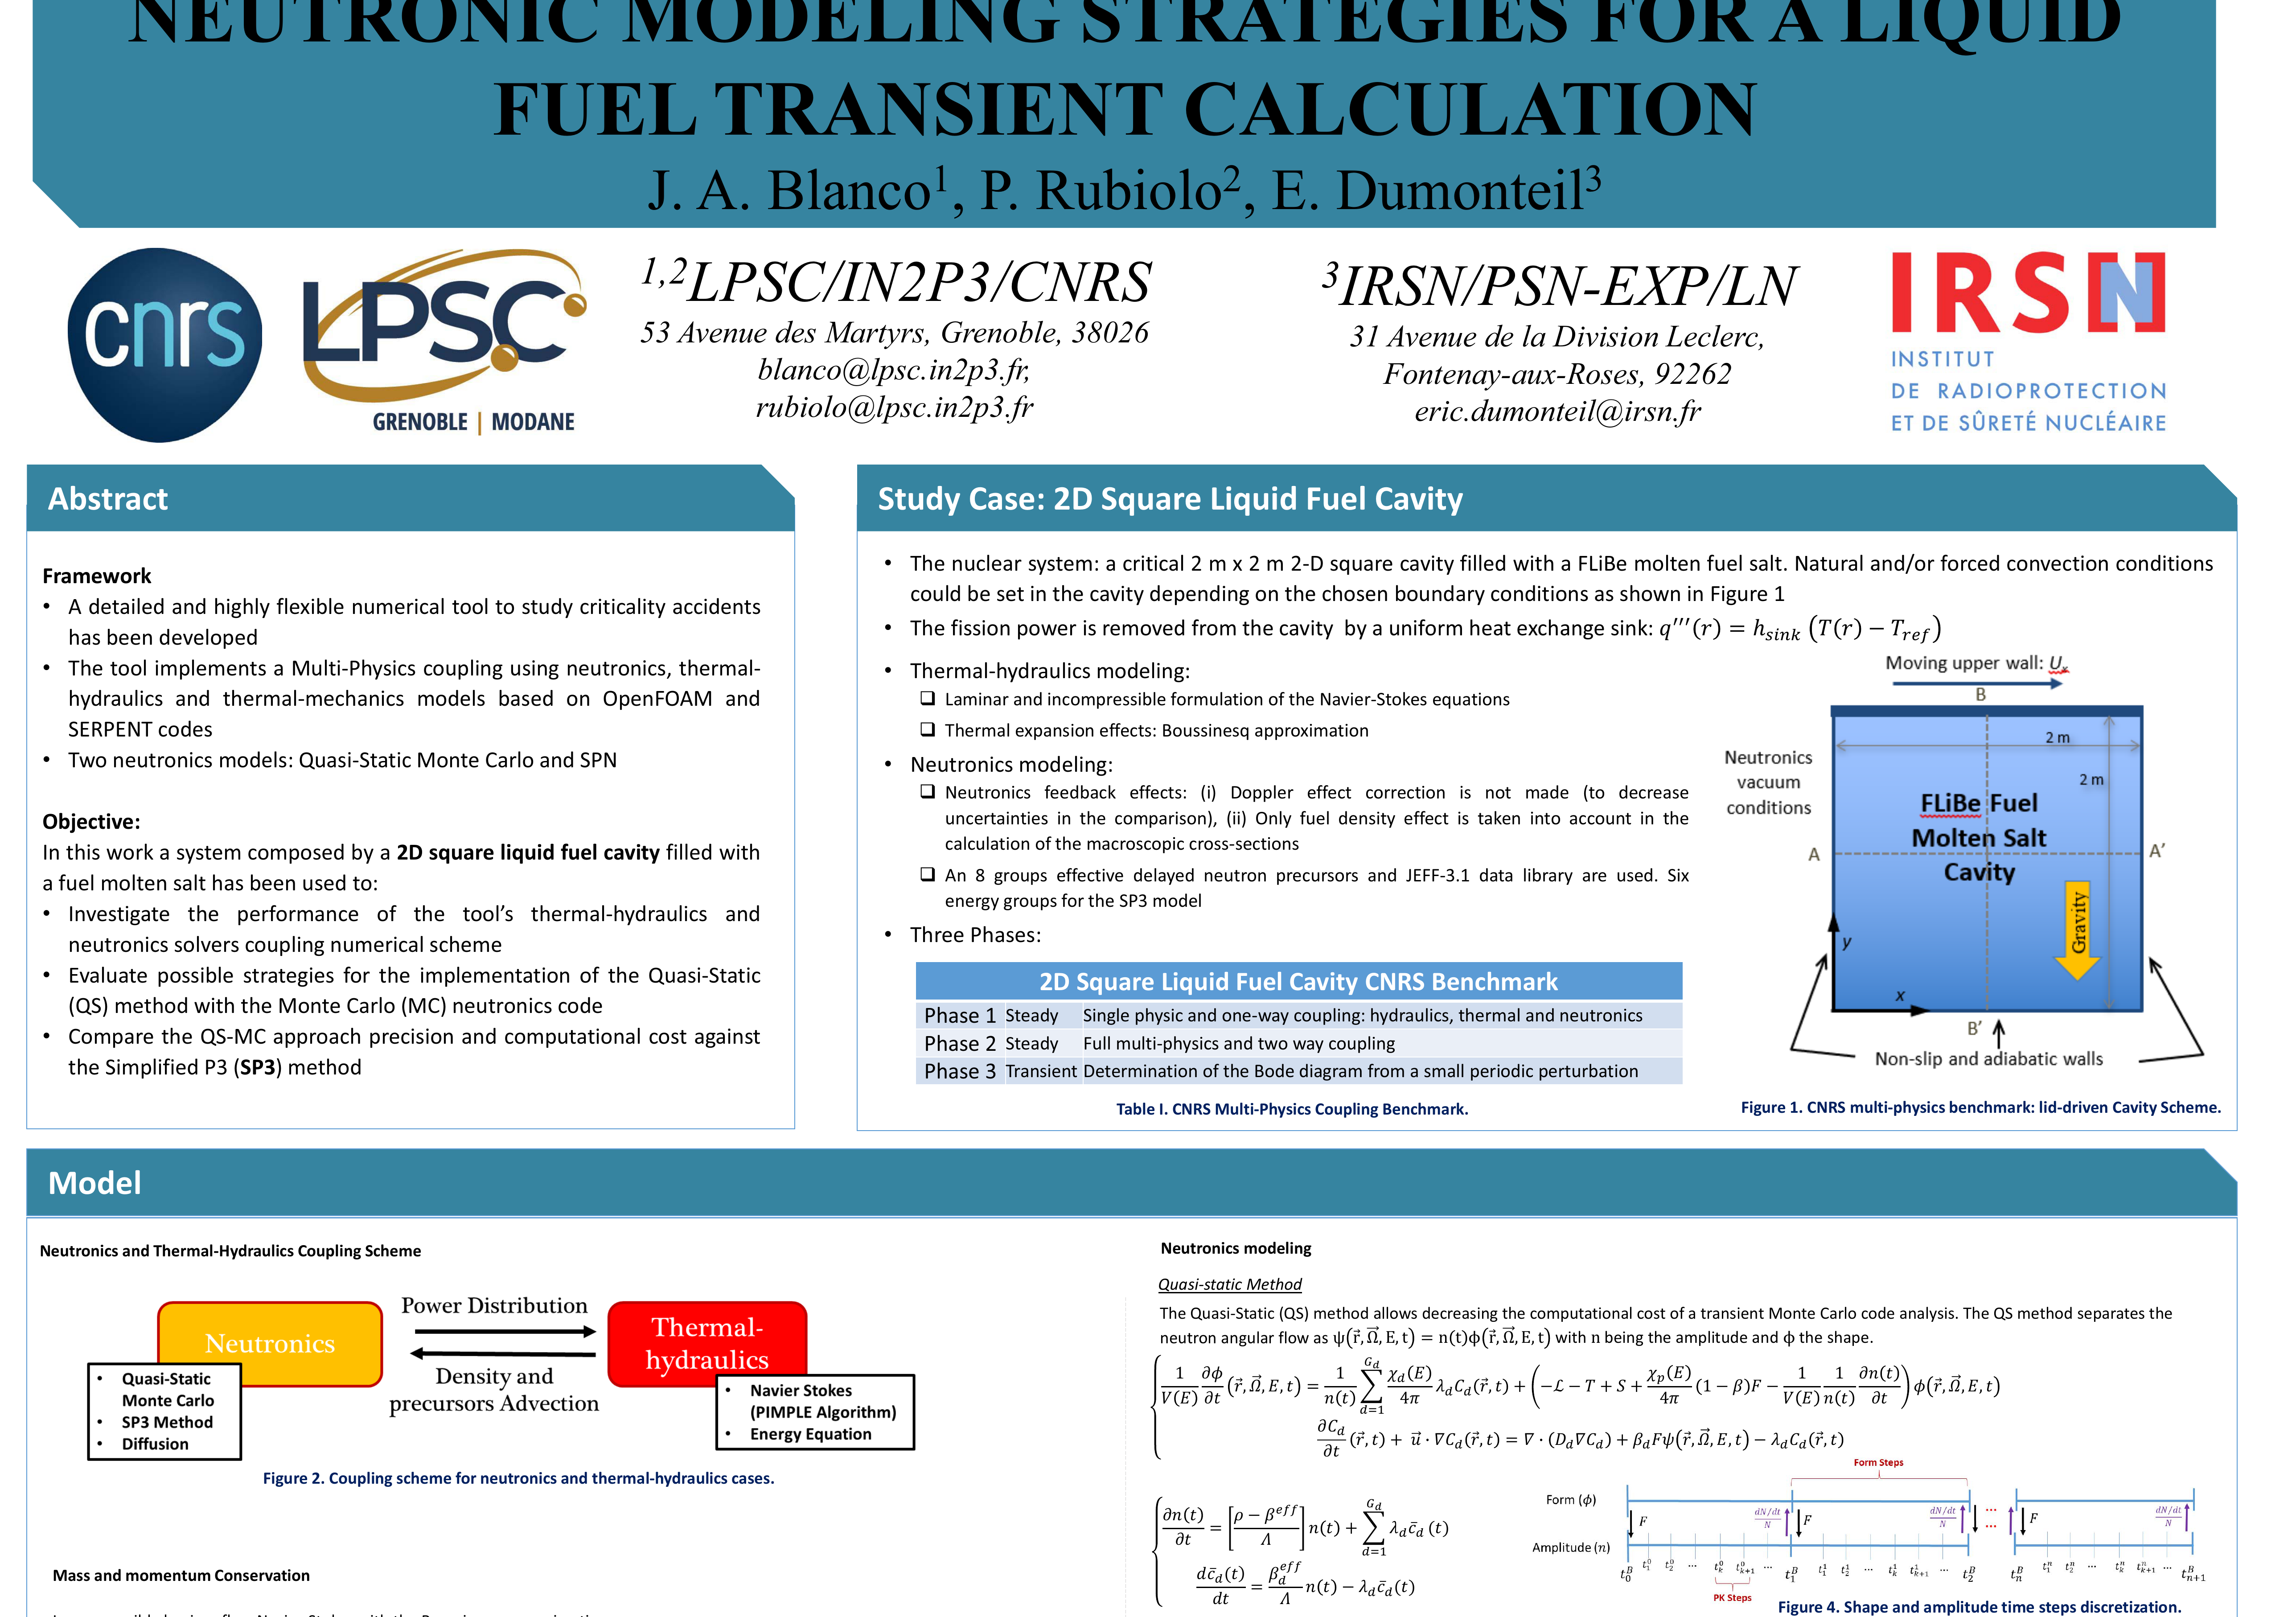
Figure 4. Shape and amplitude time steps